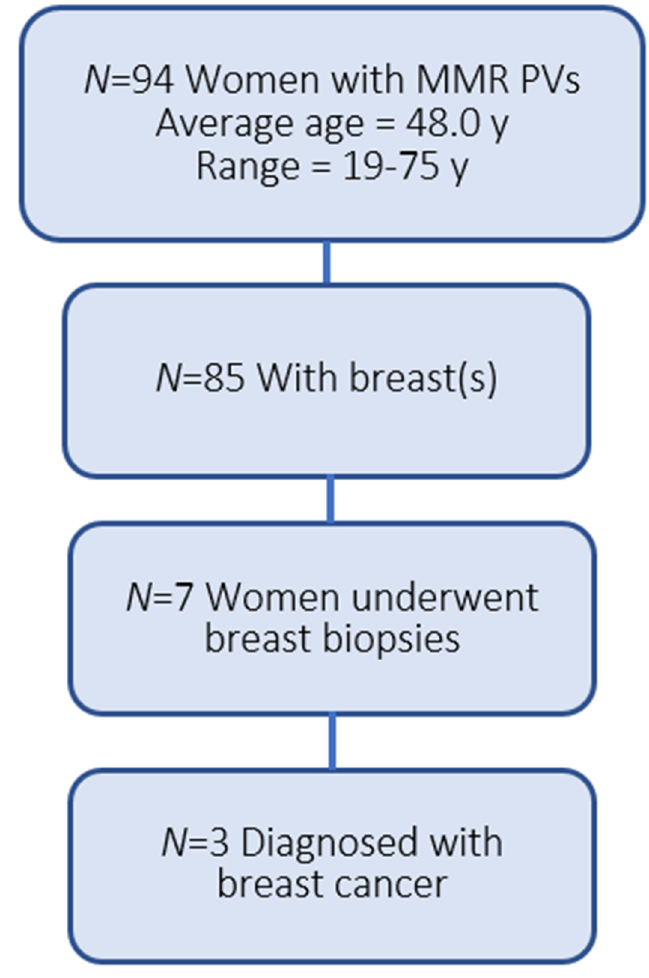
Scheme 2. The breast cancer screening and diagnosis in women with MMR gene Lynch